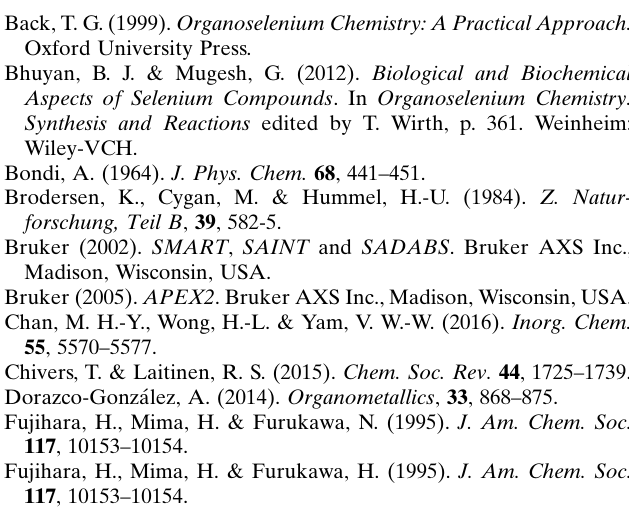
Table 1) and (cid:2) – (cid:2) stacking interactions between the benzimi- dazole rings (centroid–centroid distances = 3.535 A˚ ).